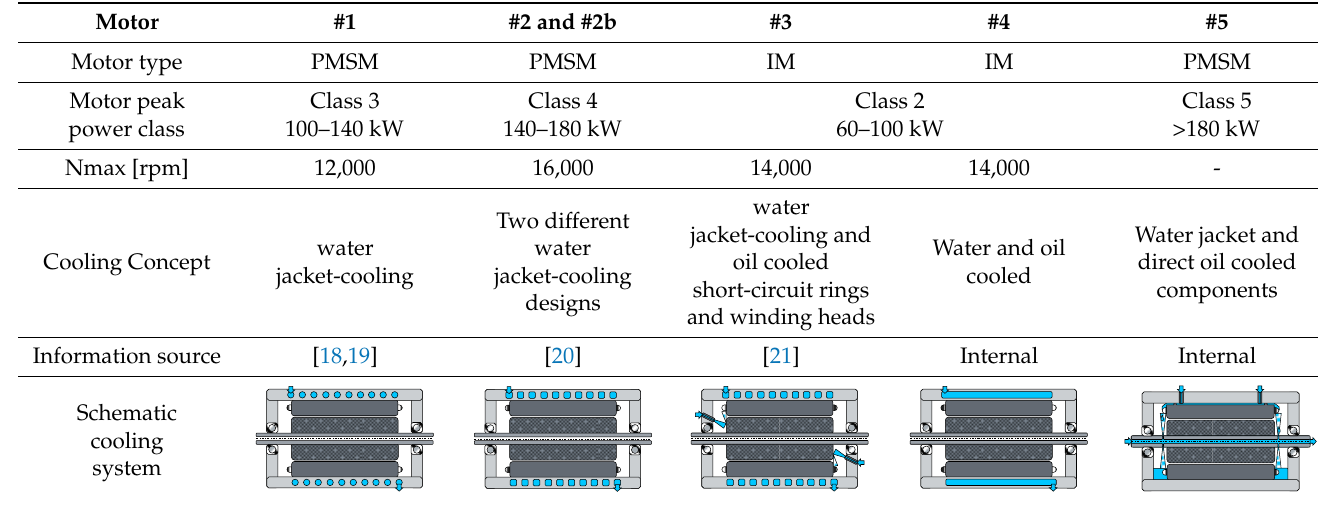
Table 4. Different electric traction motor designs.